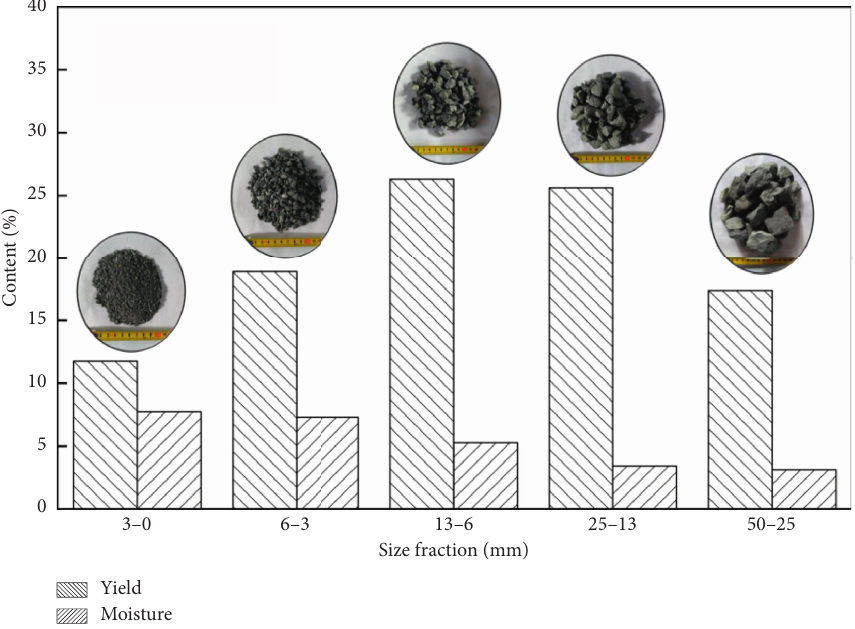
Figure 1: Materials properties of the